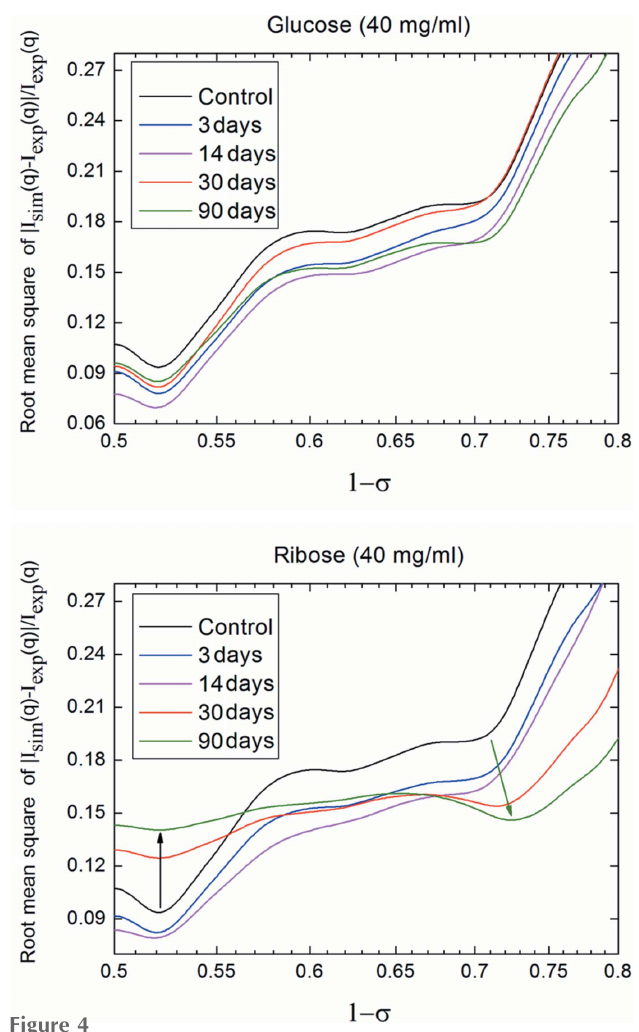
Figure 4 Variation of the mean square-root error between the theoretical curve and the experimental data as a function of the axial gap fraction (1 (cid:2) (cid:6) ), for ribose (top) and glucose (bottom), at the maximum concentration (40 mg ml (cid:2) 1 ) and different incubation times, leaving constant the other fitting parameters ( d and (cid:2) (cid:5)